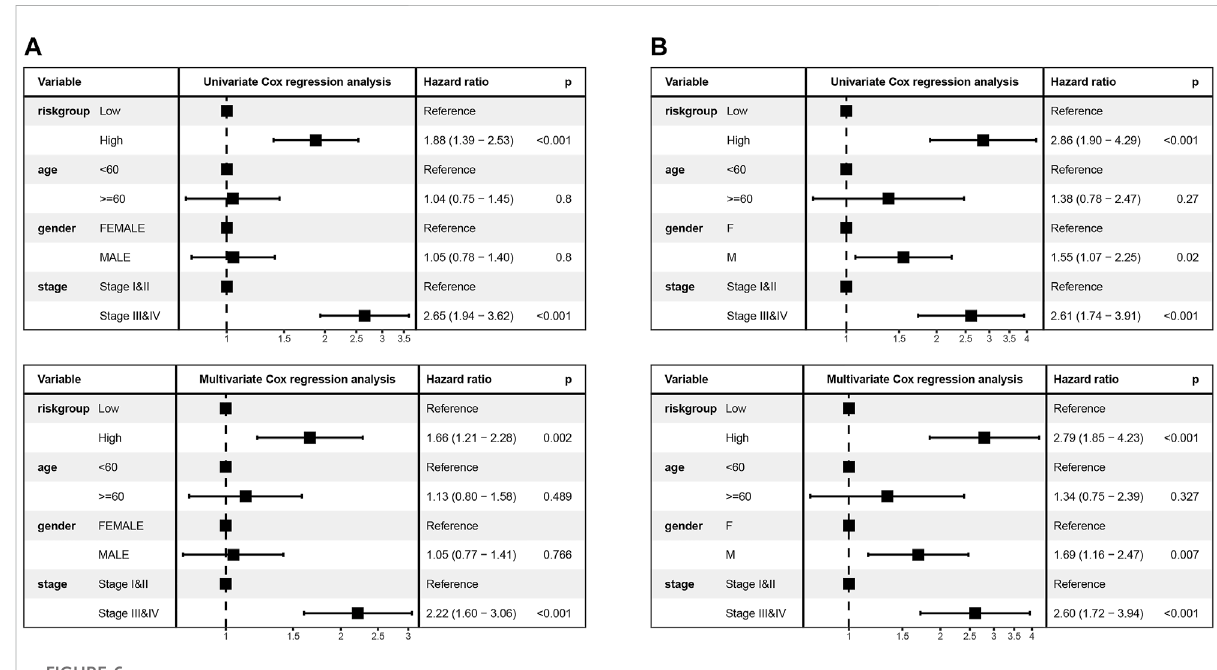
FIGURE 6 Univariate and multivariate Cox regression analyses were performed to assess the risk score and veri fi ed by validation set B (A,B) .